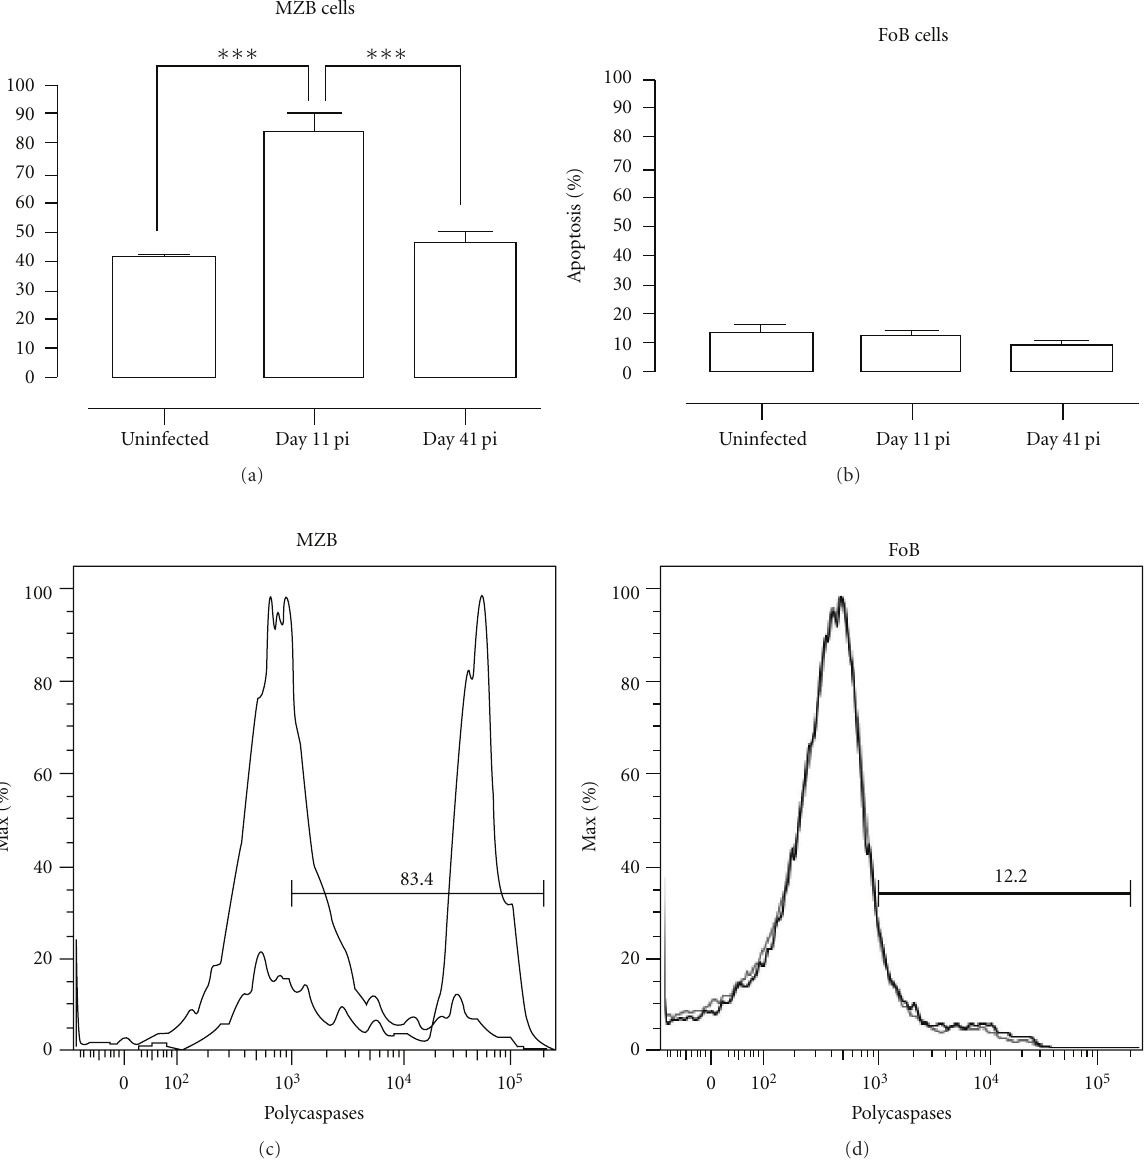
Figure 8: Pc AS infection-induced apoptosis of MZB but not FoB cells. Spleens cells from noninfected mice and mice infected with Pc AS for 11 and 41 days were stained for surface markers commonly used to define MZB and FoB cells and the amount of active caspase 1, -3, -4, -5, -6, -7, -8, and -9 was measured intracellular by flowcytometry. (a) and (b) Percentage of apoptotic cells within MZB or FoB cell population in uninfected controls versus infected mice on day 11 and 41pi. Data are represented as mean of three mice per group ± SEM ( ∗∗∗ ) P < . 001. (c) and (d) Representative histogram of uninfected controls (grey line) versus a day 11 pi (black line).